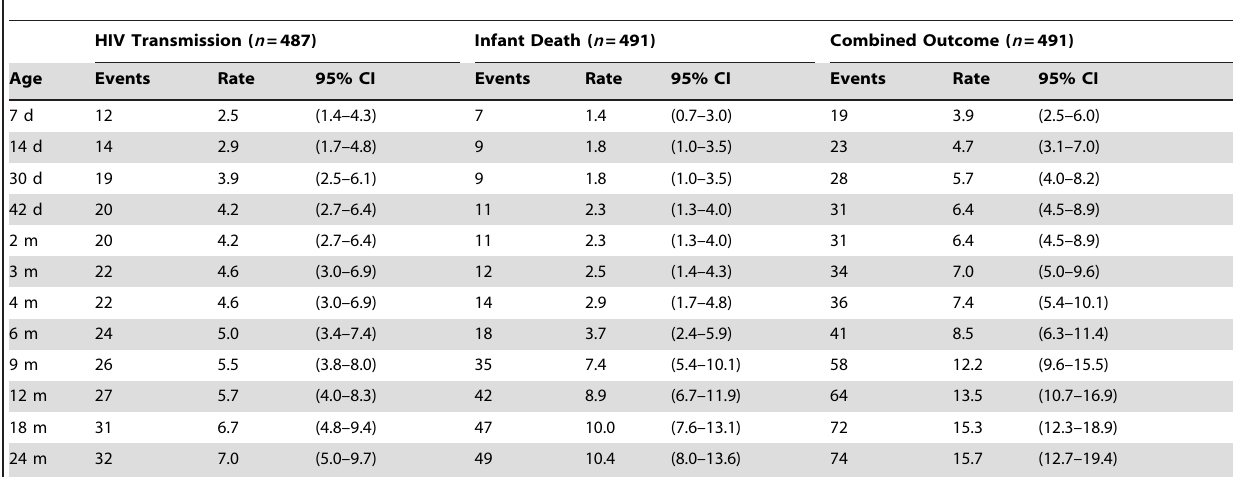
Table 3. Kaplan-Meier estimates of rates of HIV transmission and infant death.